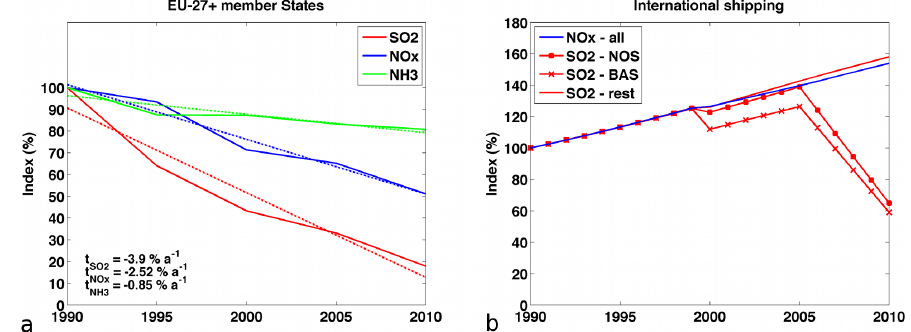
Figure 1. Emission trends of (a) SO 2 , NO x and NH 3 in the EU-27 + member states and (b) SO 2 and NO x in international shipping for 1990–2010 in % with 1990 as reference. The dashed lines in (a) show the average trend computed over the entire period and the decrease per year is displayed as